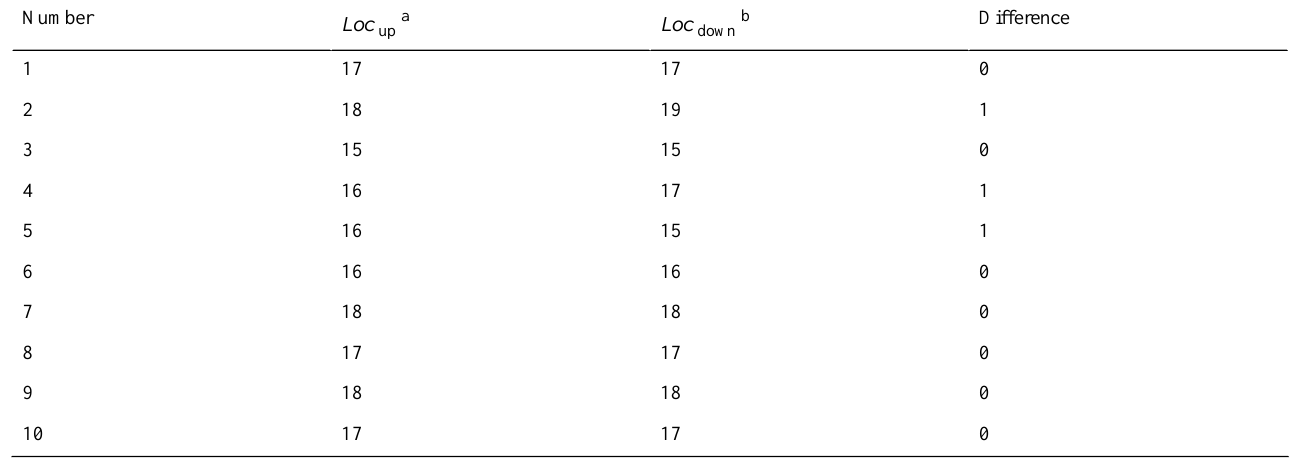
Table 4. Results of respiration rate estimation by